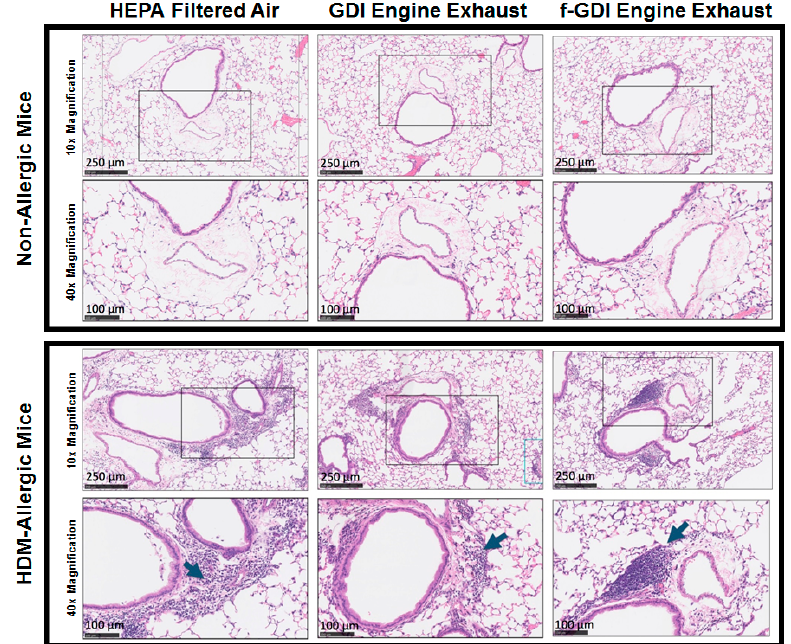
Figure 3. Enhanced inflammation induced by sensitisation to HDM. Hematoxylin and Eosin staining demonstrated increased peribronchial and perivascular inflammatory infiltrates in HDM-allergic animals as compared to non-allergic mice. Cell infiltration is indicated by blue arrows. High power images (40× magnification, Rows 2 and 4) are representative of the boxed regions in the low power images (10× magnification, Rows 1 and 3). These images are representative samples of the three exposure groups.